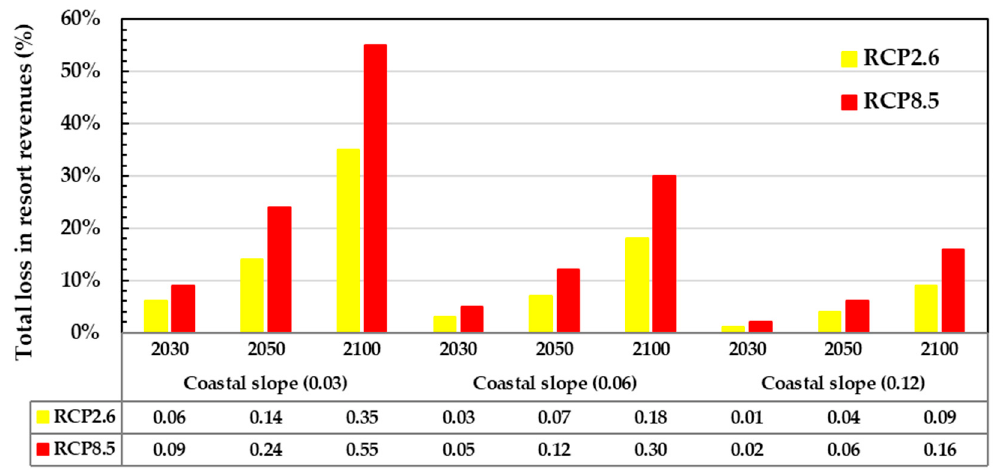
Figure 5. Expected total loss in resort revenues (%) in 2030, 2050, and 2100 for the RCP2.6 and RCP8.5 SLR scenarios and coastal slopes 0.03, 0.06, and